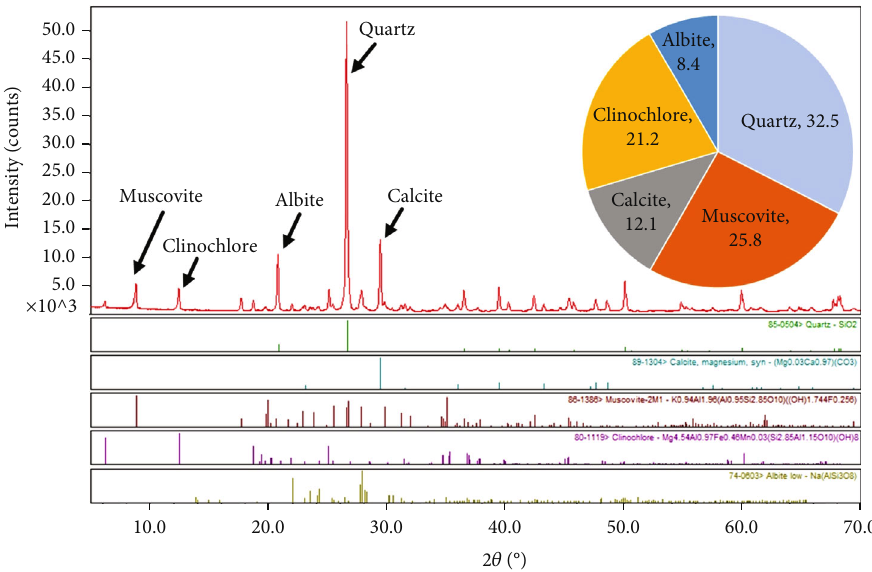
Figure 1: Mineralogy analysis of shale sample.